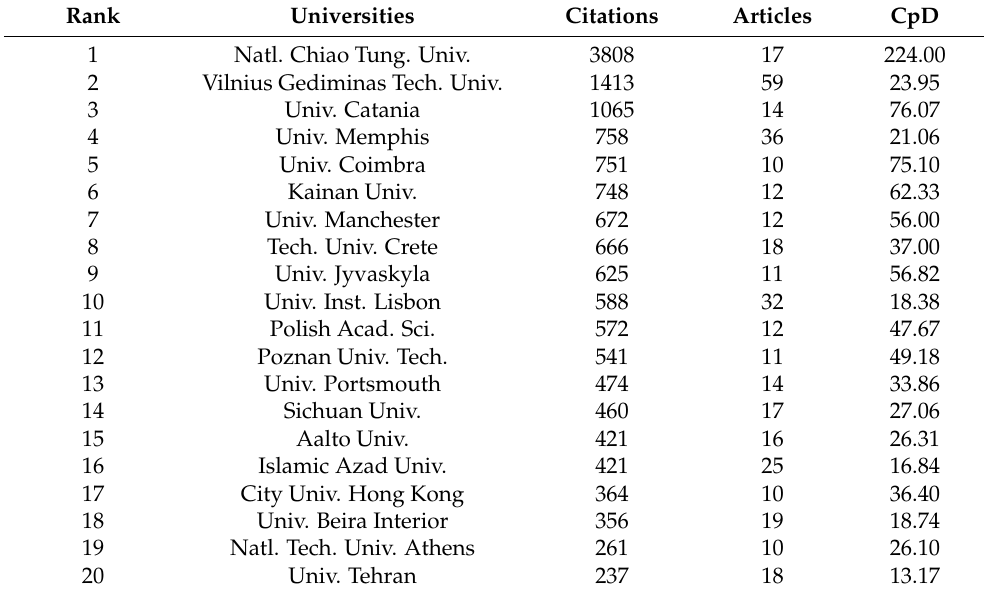
Table 3. Academic production of universities with more than 10